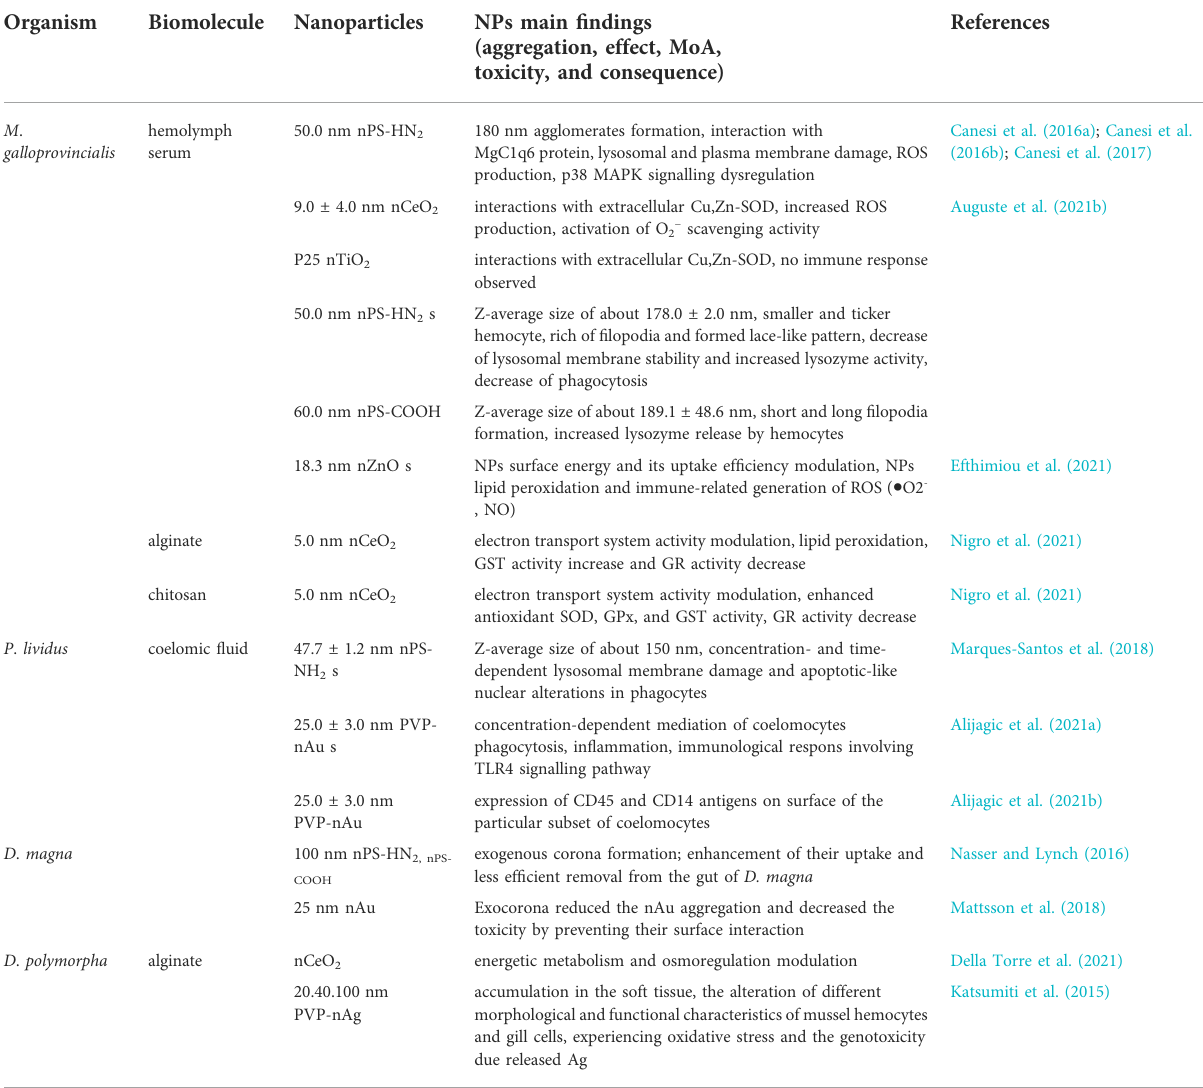
TABLE 2 Selected examples of biological effects and toxicological consequences of nanoparticles coated with different biomolecules and nature of formed biocorona in marine and freshwater invertebrates.